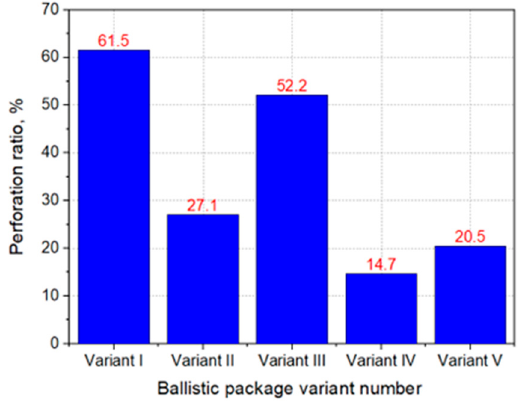
Figure 9. The perforation factor for individual variants of ballistic packages.